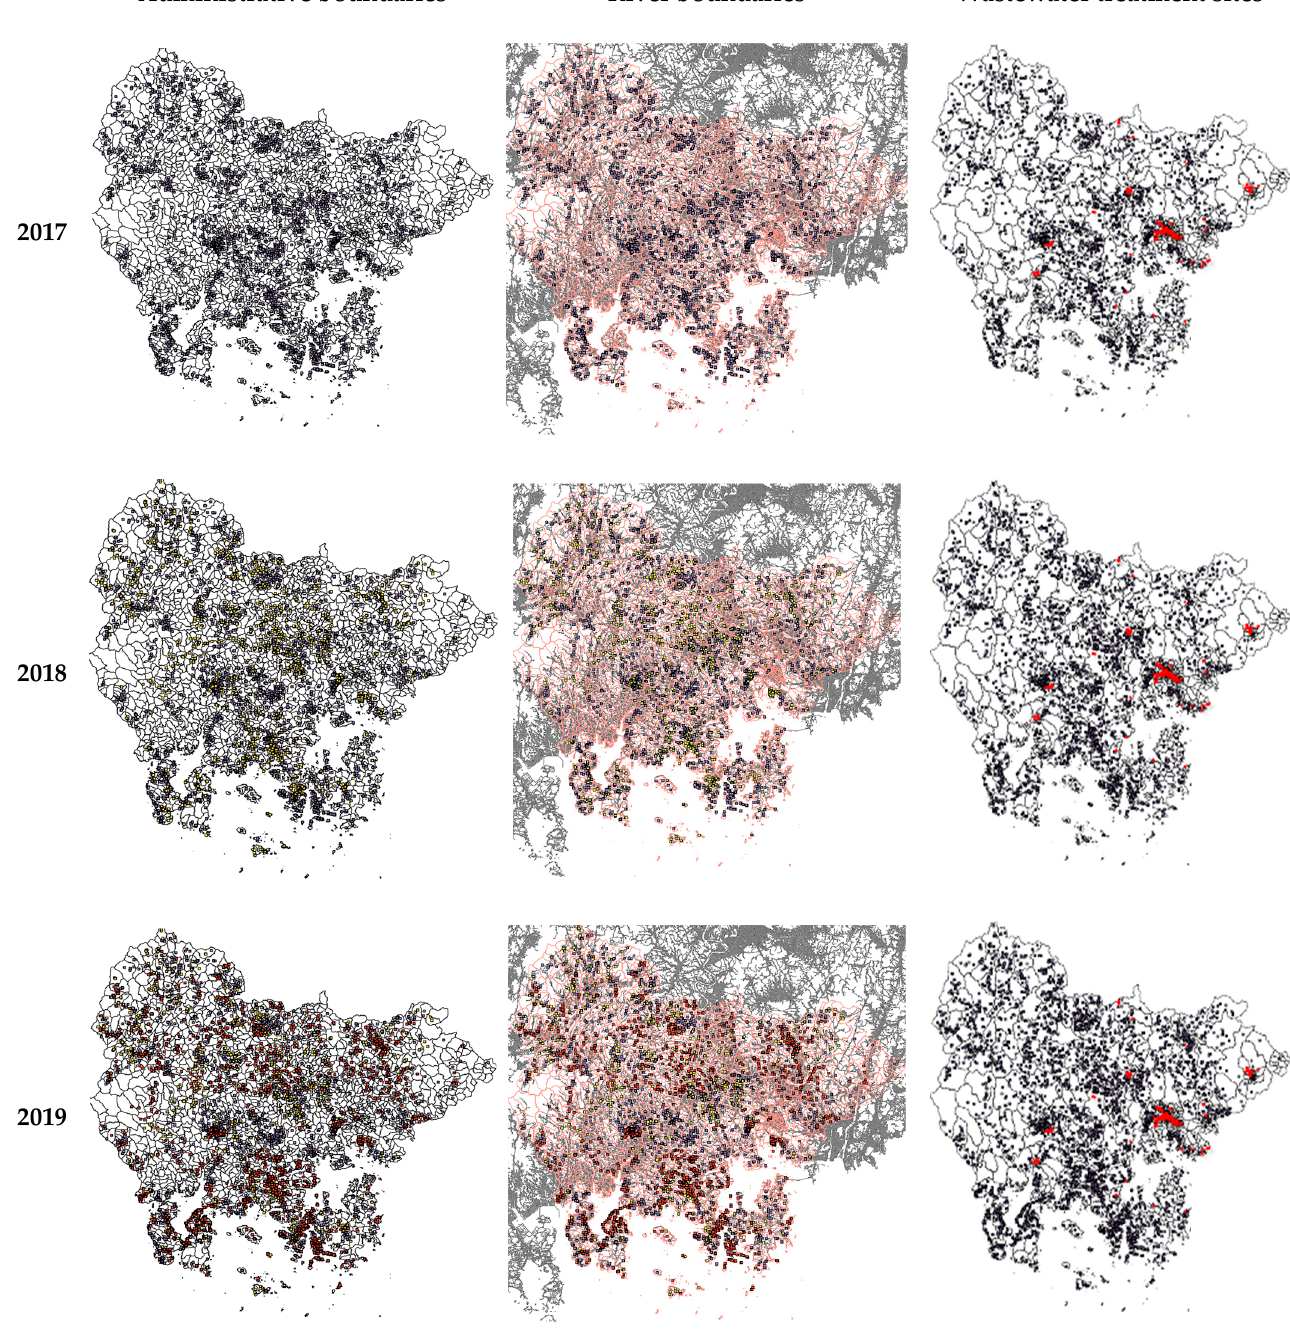
Figure 5. Abandoned house distribution according to spatial information.